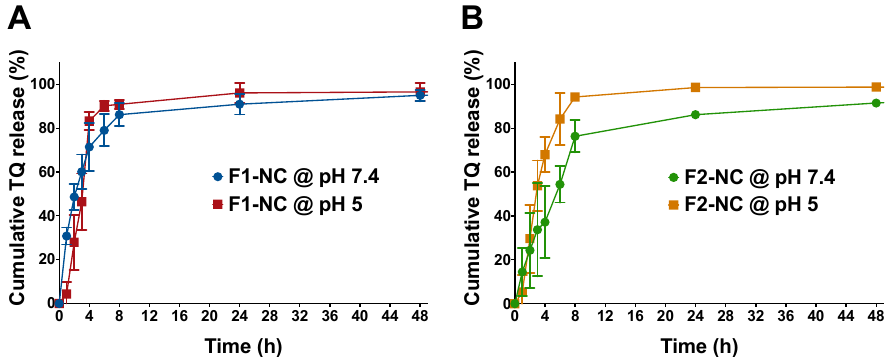
Figure 5. In Vitro release of TQ NPs conducted in phosphate buffered saline (PBS) (pH 7.4) and acetate buffer (pH 5.0). Results are presented as mean ± SD of cumulative % amount of TQ released from ( A ) F1-NC and ( B ) F2-NC up to 48 h. The PCL MW impacted the release kinetics. F1-NC with a shorter PCL chain achieved 86–90% cumulative release within the first 8 h in neutral and acidic media, respectively. Conversely, TQ release from F2-NC with the longer PCL chain was more sustained at pH 7.4, reaching 76% cumulative release within the first 8 h and 86% release after 24 h, which was accelerated in acidic media to 94 and 99% at 8 and 24 h, respectively.